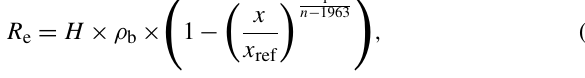
Figure 7. Erosion rates estimated using our empirical model (Eq. 2) vs. measured erosion rates on arable land. Measured erosion rates were calculated from 137 Cs inventories (Eq.